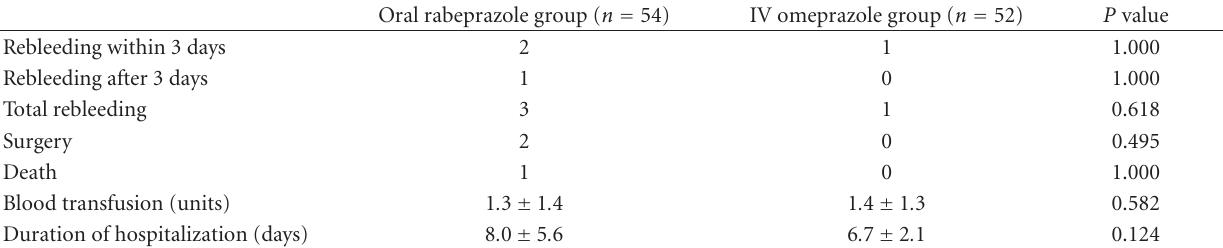
Table 3: Outcomes in the study patients with a bleeding peptic ulcer (ITT